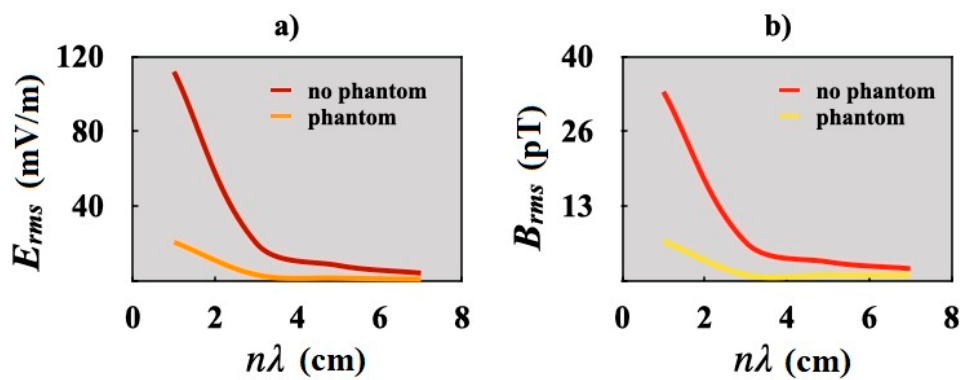
Figure 7. Comparison plots of electric fields versus distance ( a ) and magnetic field ( b ) with and without phantom.